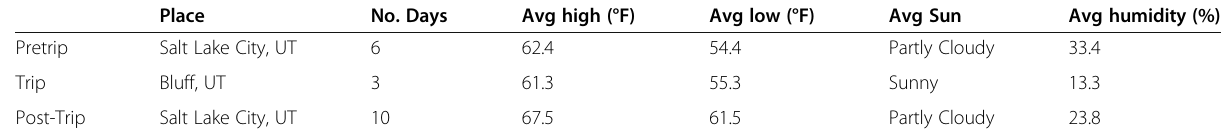
Table 3 for all eyes-closed mixed model